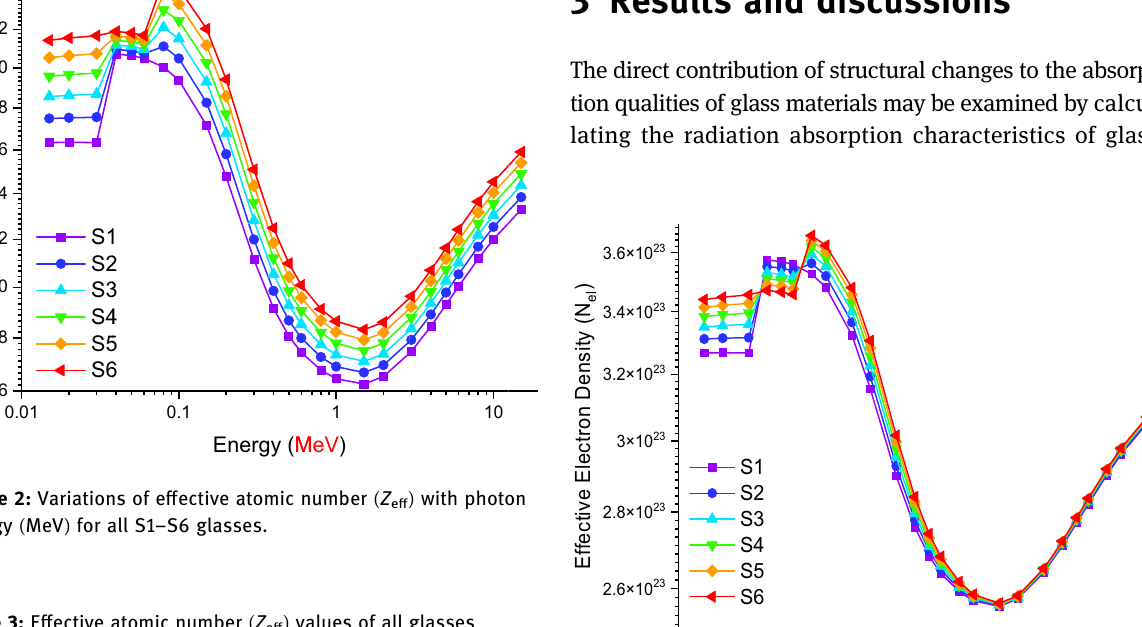
Table 3: E ff ective atomic number ( Z e ff ) values of all glasses